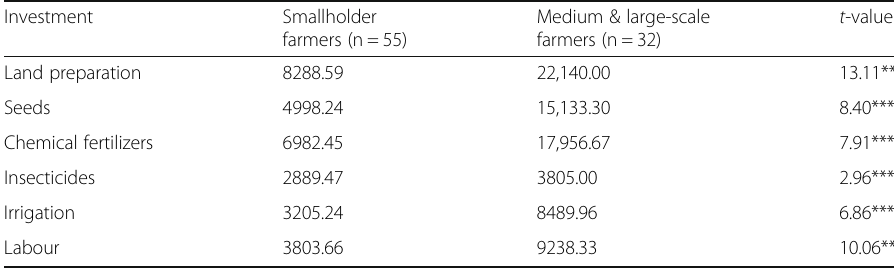
Source: Field survey data,